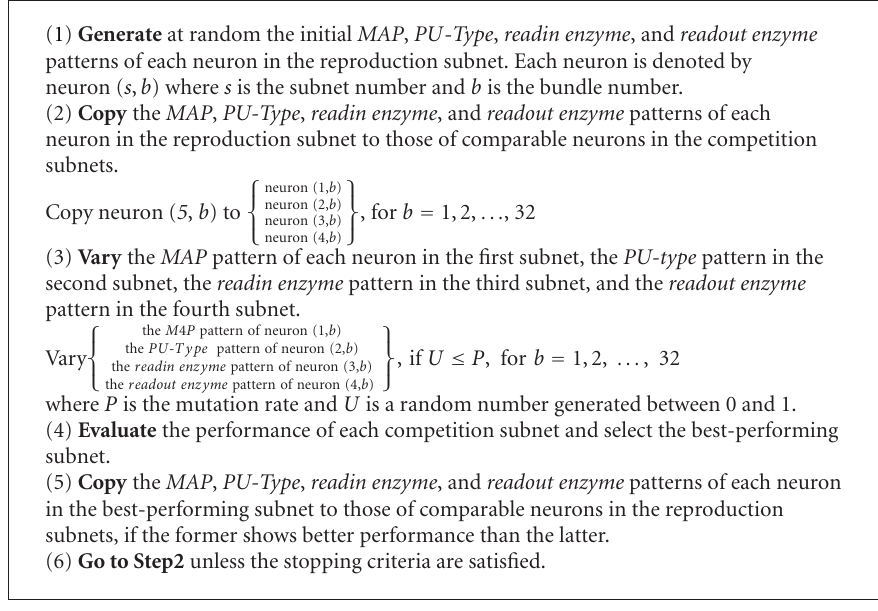
Algorithm 1: Evolutionary learning